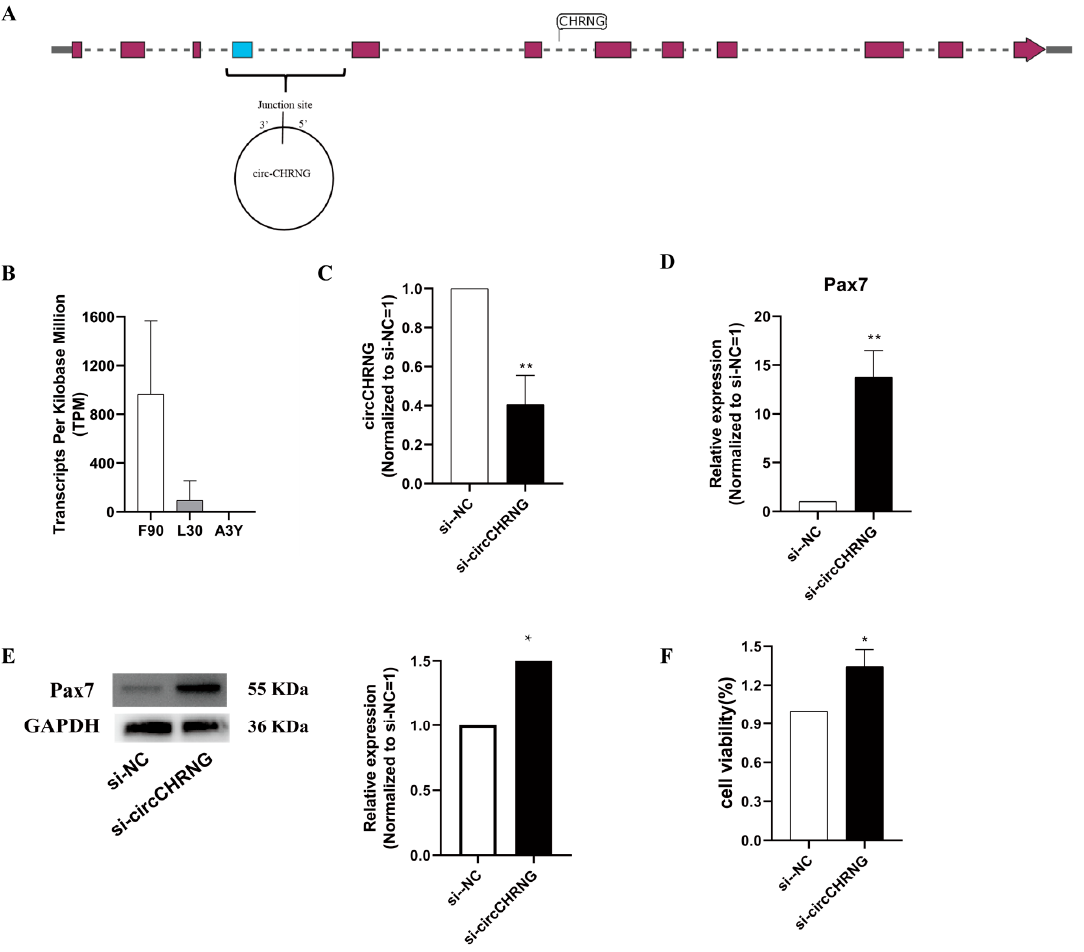
Figure 5. Knockdown of circCHRNG promoted the proliferation of ovine skeletal muscle satellite cells (SMSCs). ( A ) circCHRNG. ( B ) The expression level of circCHRNG in skeletal muscle from F90 to A3Y. ( C ) siRNA of circCHRNG decreased the expression level of circCHRNG. ( D ) Inhibition of circCHRNG increased the mRNA expression level of PAX7. ( E ) Inhibition of circCHRNG increased the protein expression level of PAX7. ( F ) MTT assays for vine skeletal satellite cells transfected with si-circCHRNG or si-NC. p < 0.05 was considered to be statistically significant. * p < 0.05, ** p < 0.01.